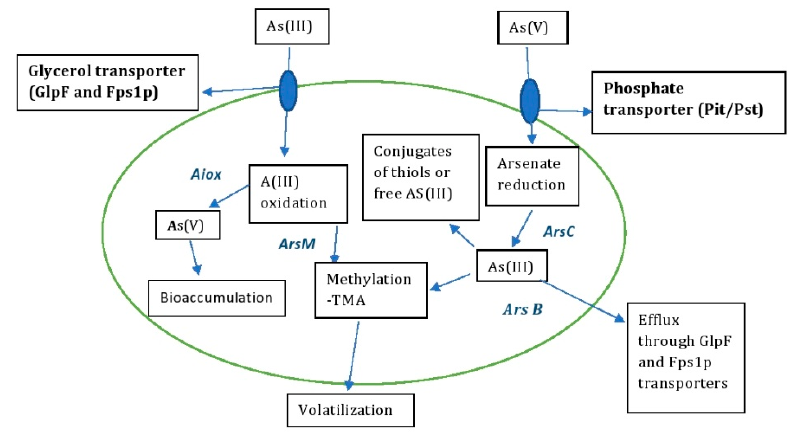
Figure 4. Arsenic detoxification mechanism by microbes—bioremediation.